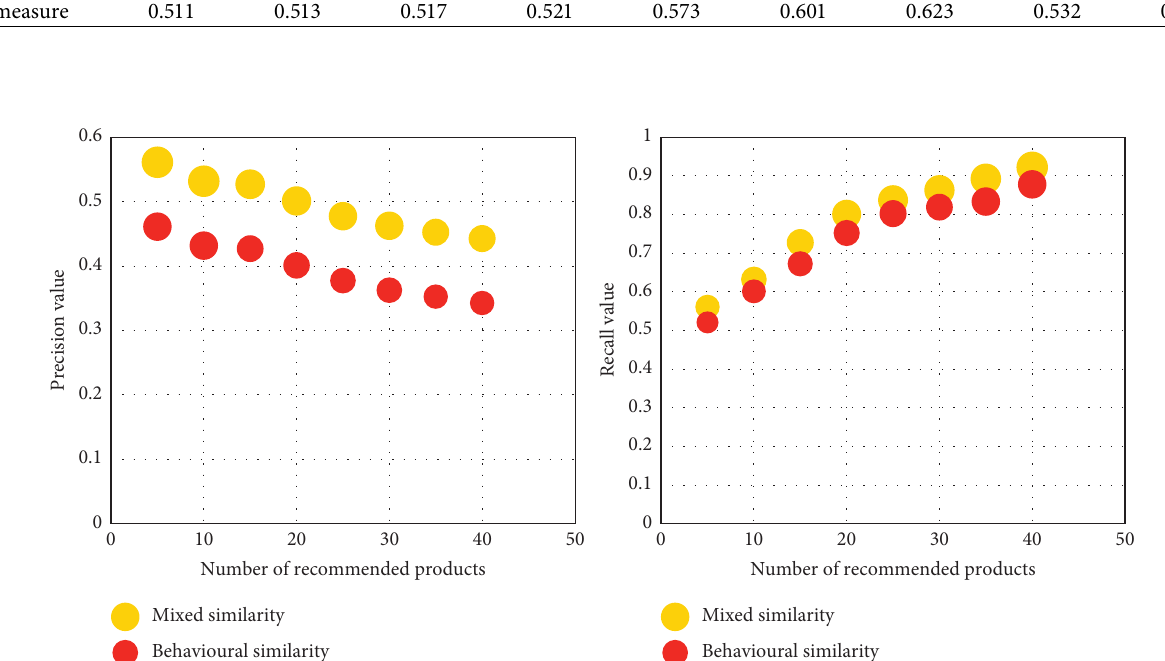
Figure 7: Analysis of the results of the behavioural similarity of the traditional collaborative filtering algorithm and the mixed similarity of the algorithm in this